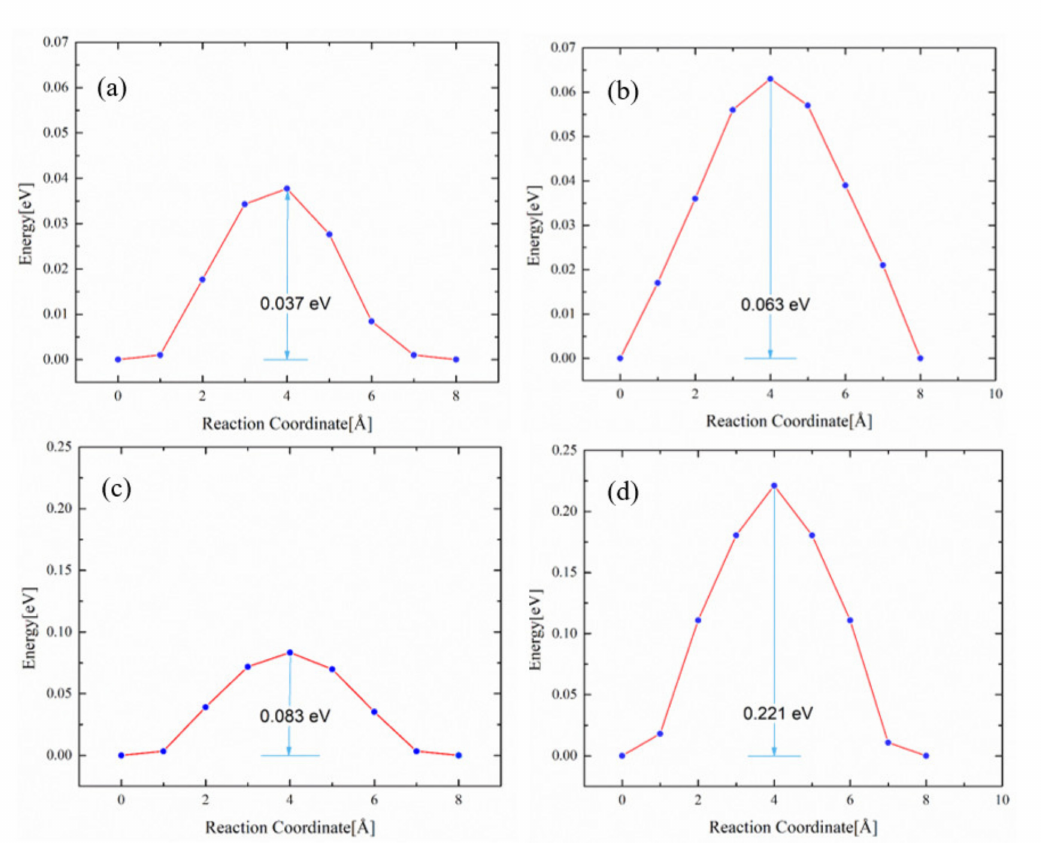
Figure 7. Calculated diffusion energy profiles for a Na atom diffusion on different surfaces: ( a ) Na diffusion on pure Mo (110) surface; ( b ) Na diffusion on Mo-Re (110) surface; ( c ) Na diffusion on Mo (110) surface with an adsorbed O atom; ( d ) Na diffusion on Mo-Re (110) surface with an adsorbed O